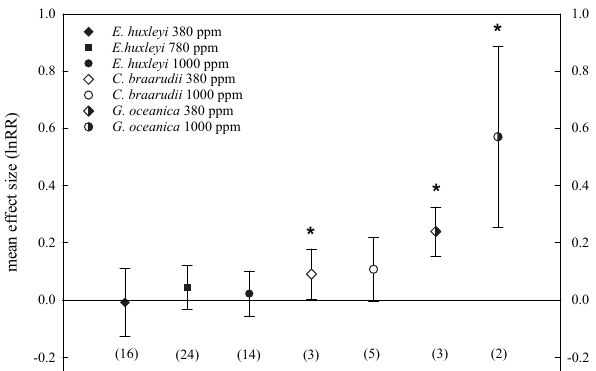
Figure 2. Mean effect of elevated CO 2 concentrations (relative to 280 ppm) on the photosynthesis rates of three coccolithophores: Emiliania huxleyi , Coccolithus braarudii and Gephyrocapsa ocean- ica. Error bars denote the 95% confidence intervals. * indicates a significant response, which is given when the confidence interval does not overlap zero. The number of experiments included in the meta-analysis is shown in parentheses. The zero line indicates no